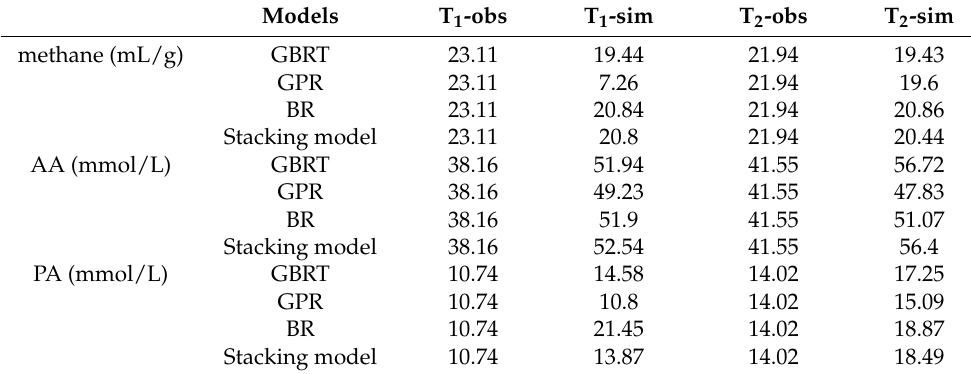
Table 5. The comparison of simulated values from different